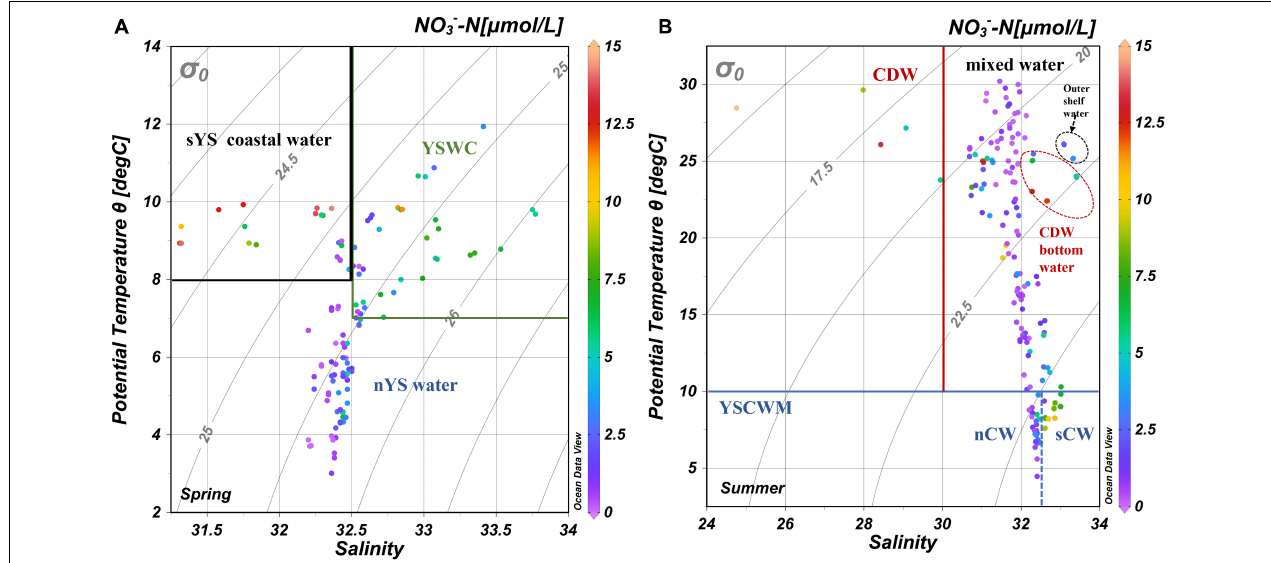
FIGURE 3 | Water masses in the Yellow Sea in spring (A) and summer (B) , note that the ranges of axes for spring and summer are different. sYS, south Yellow Sea; nYS, north Yellow Sea; YSWC, Yellow Sea Warm Current; CDW, Changjiang Diluted Water; YSCWM, Yellow Sea Cold Water Mass. nCW, north Cold Water mass; sCW, south Cold Water mass. In summer, the YSCWM can be divided into nCW and sCW located in nYS and sYS, respectively, with nitrate in nCW being lower than in